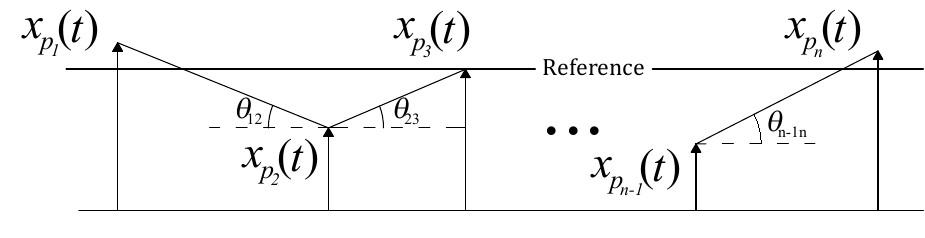
Figure 3. Illustration of the alignment